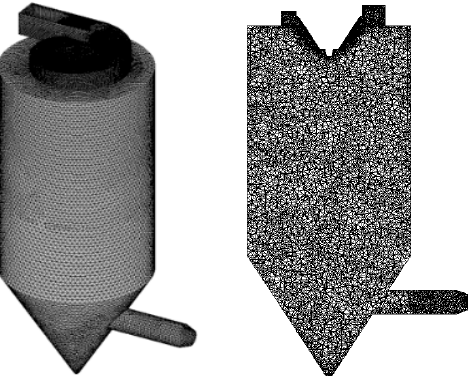
Figure 3. Grid division of this spray drying tower without deflectors. Table 2. Case setting.